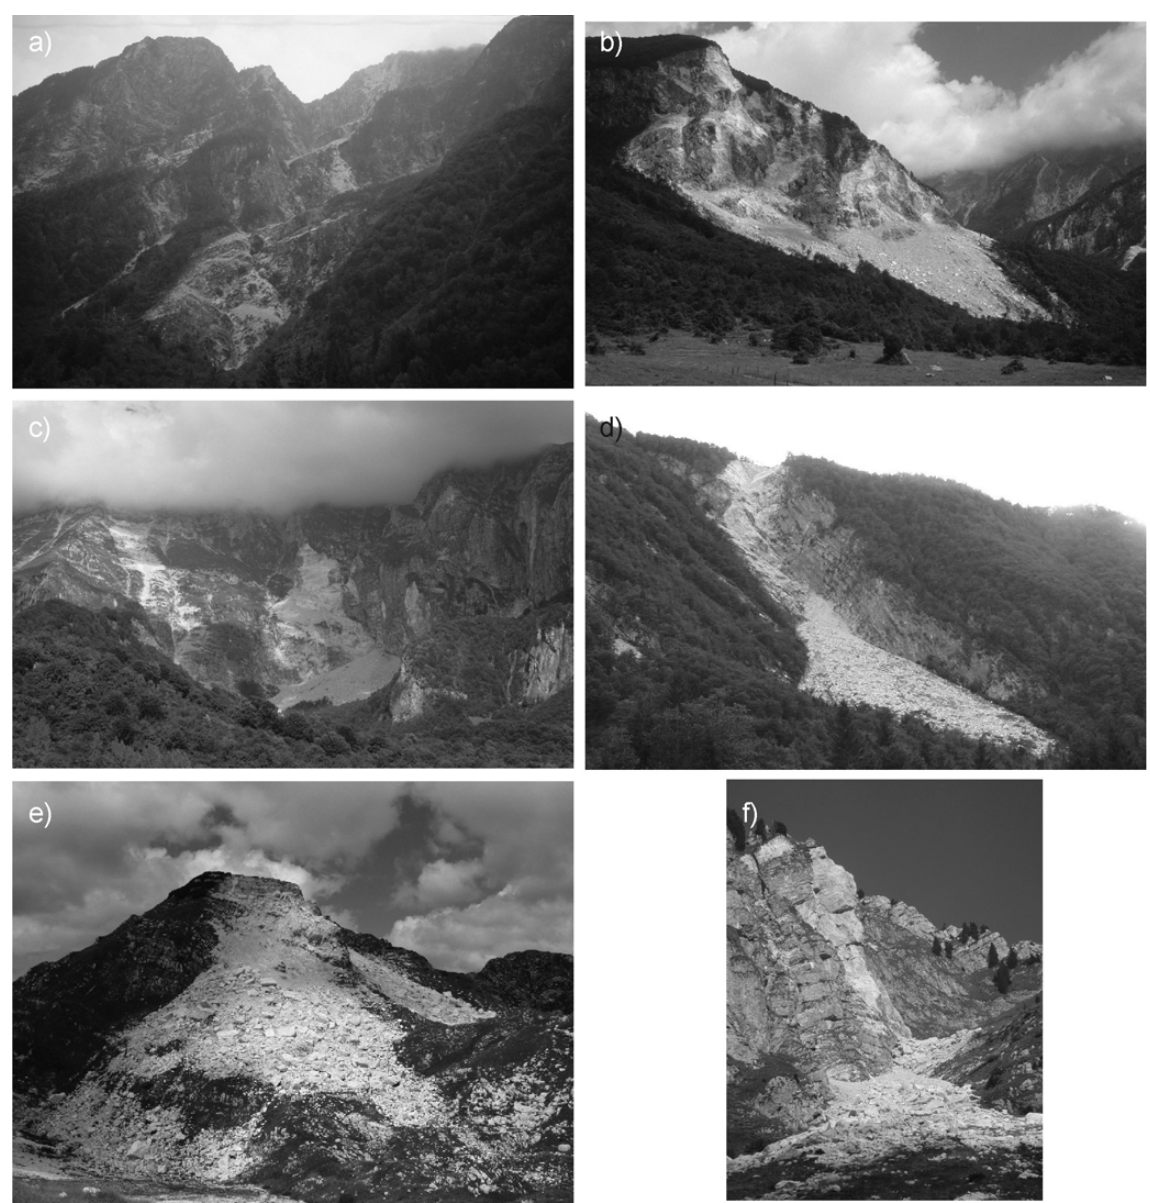
Fig. 5. Selection of largest rockfalls with assigned intensities in brackets. (a) V. Lemeˇz (VIII), (b) Osojnica (VIII), (c) Krn (VII), (d) ˇSkril (VII), (e) V. ˇSmohor (VI), (f) Lipnik